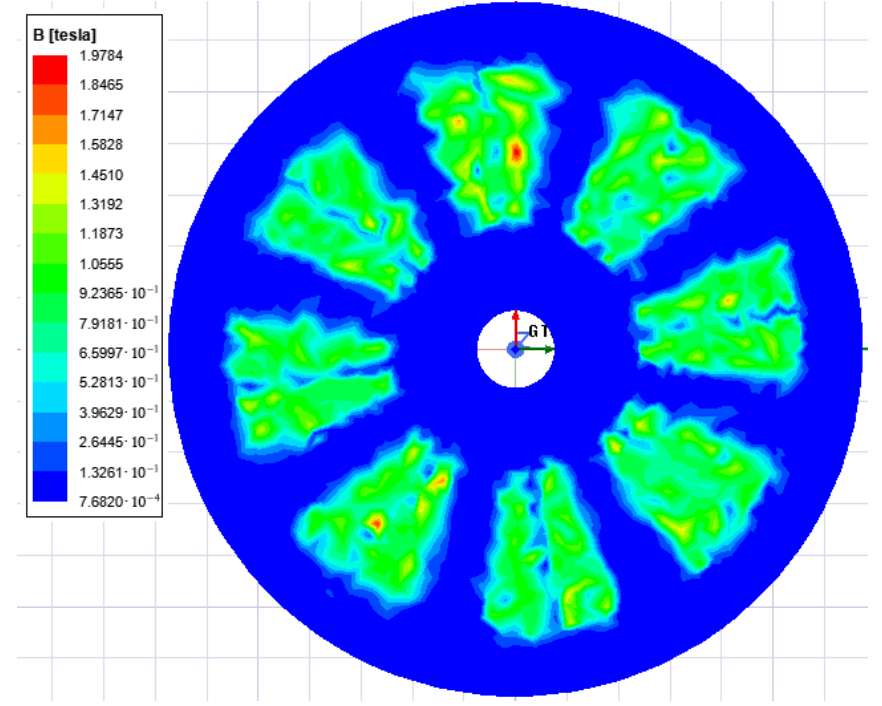
Figure 7. Magnetic flux density in air